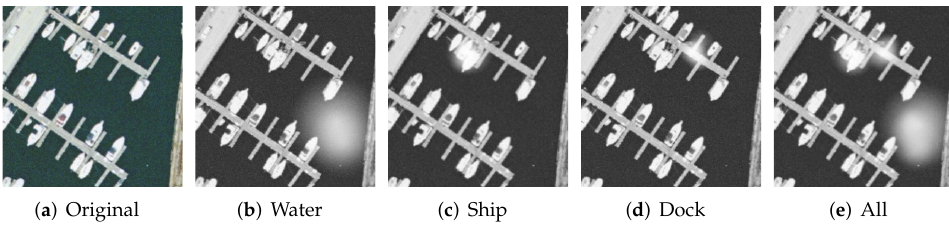
Figure 7. The picture “harbor33” in UC-Merced [16,17] dataset and its attention parts generated by